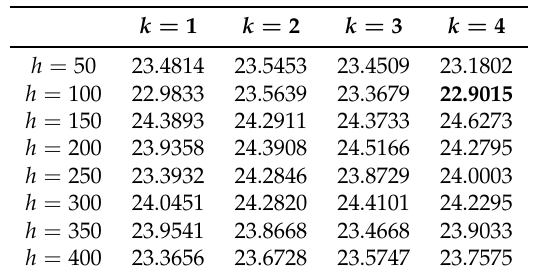
Table 1. Root-mean-square errors (RMSEs) of the 30 min experiment with various numbers of hidden layers and hidden units.